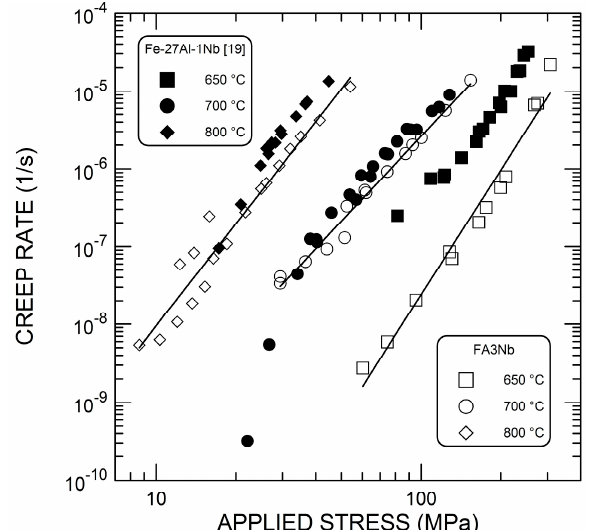
Figure 9. Comparison of the creep rate variation with the applied stress for the present alloy FA3Nb and Fe-Al-based alloy containing 1% of Nb [19].